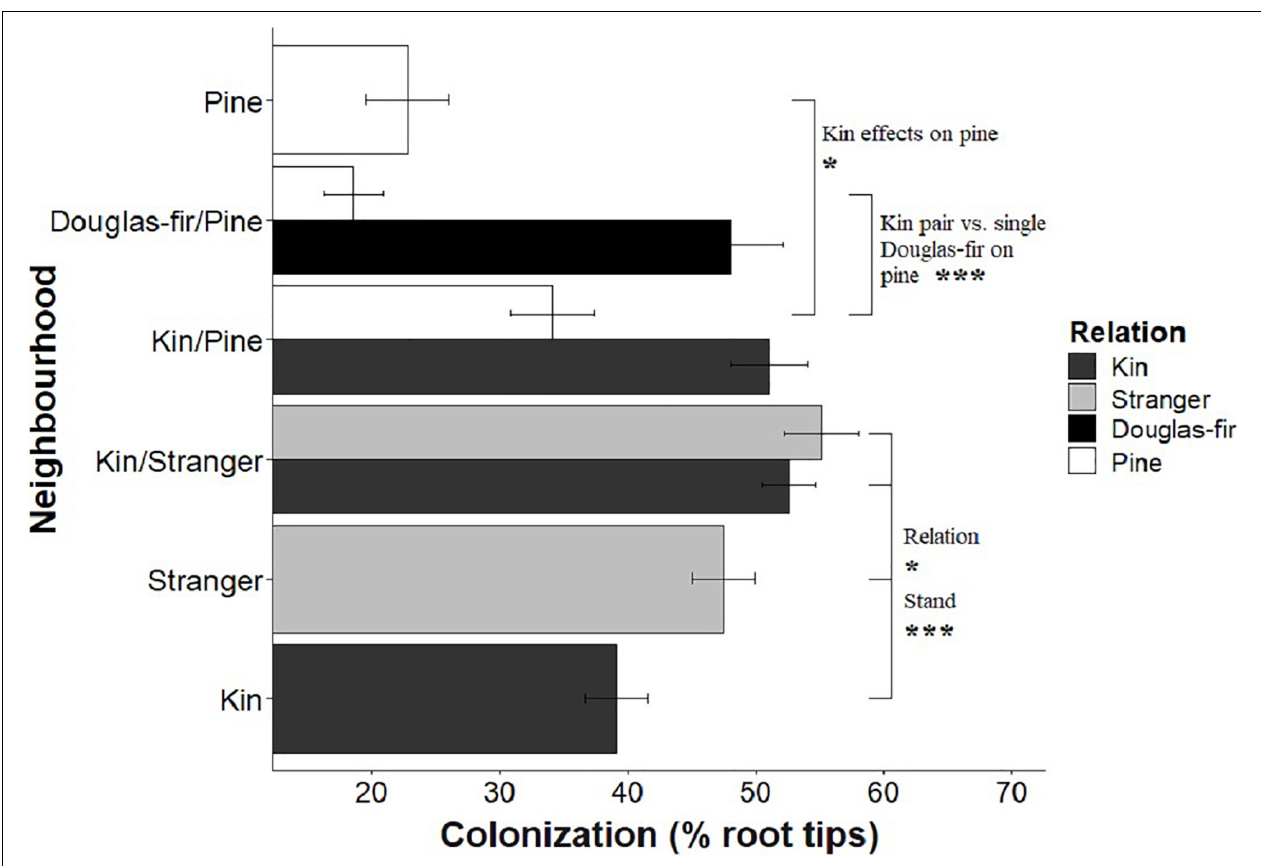
FIGURE 5 | The effect of neighborhood treatments on the colonization for Douglas-fir seedlings (shaded) and pine seedlings (white). Significant planned contrasts are shown. Relation contrasted kin with stranger seedlings (estimate = 10.9, t ratio = 2.22, p = 0.0276, Df = 206). Stand contrasted seedlings grown in pure stand with those in mixed stands (estimate = –21.1, t ratio = –4.29, p < 0.0001, Df = 206). Pine seedlings grown with a pair of kin had less biomass than those grown in pairs of pine with a single Douglas-fir and less than pine grown in pure pine stands. * p < 0.05 and *** p <